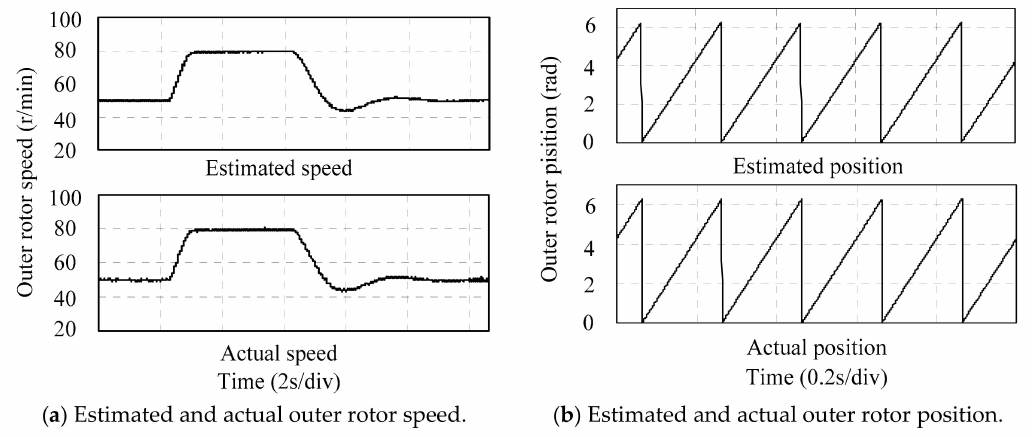
Figure 12. Experimental results of the outer rotor under the SM-MRAS sensorless control.